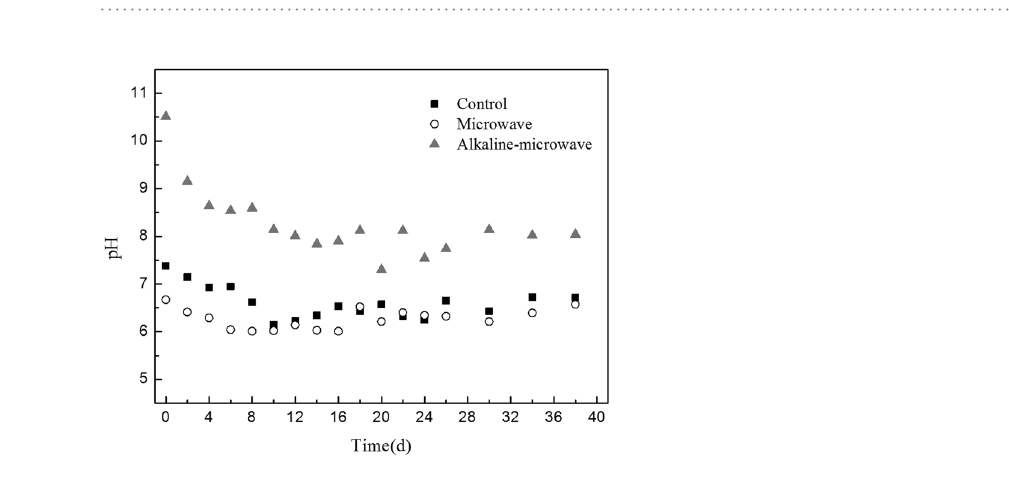
Figure 1. Analysis of Response surface methodology: interactive effects of pH and E on DD. ( a ) 3D response surface; ( b ) Verification result of RSM predicts and determined.